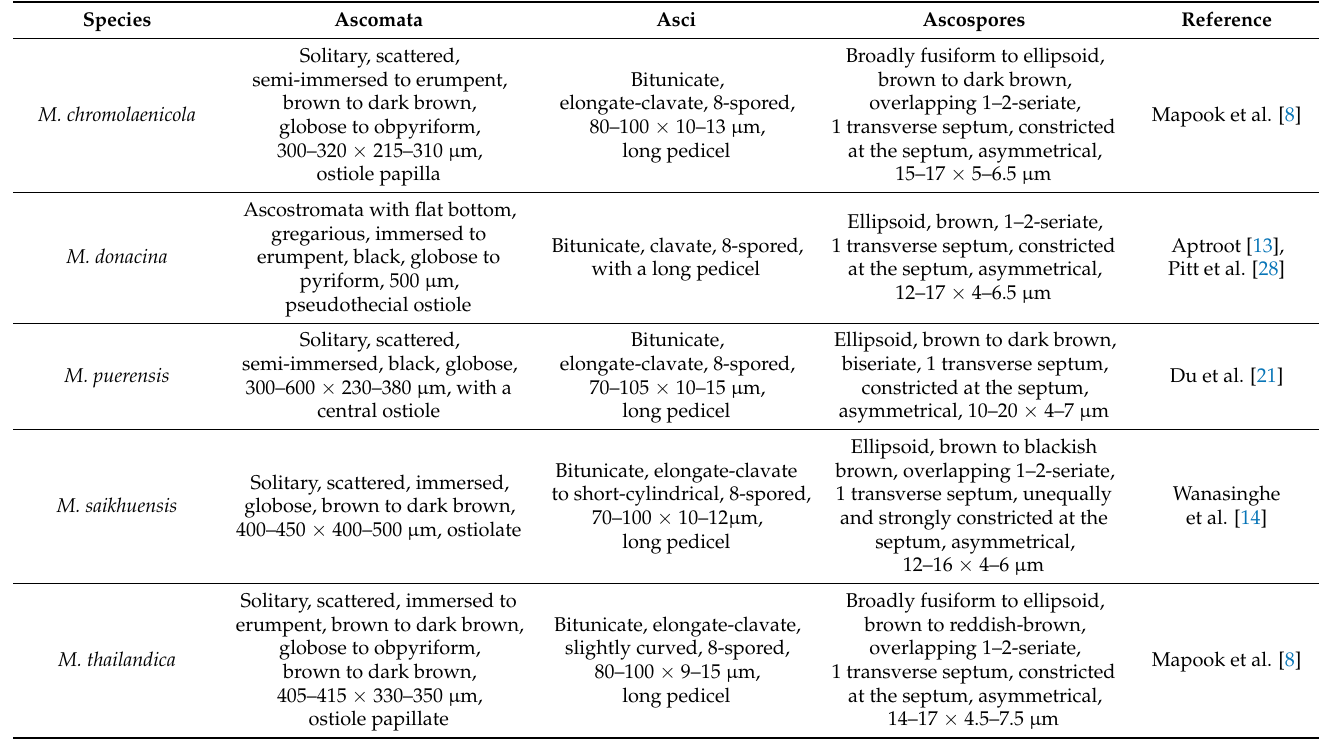
Table 3. Morphological comparison of M. donacina and M. chromolaenicola , M. puerensis , M. saikhuensis , and M. thailandica .